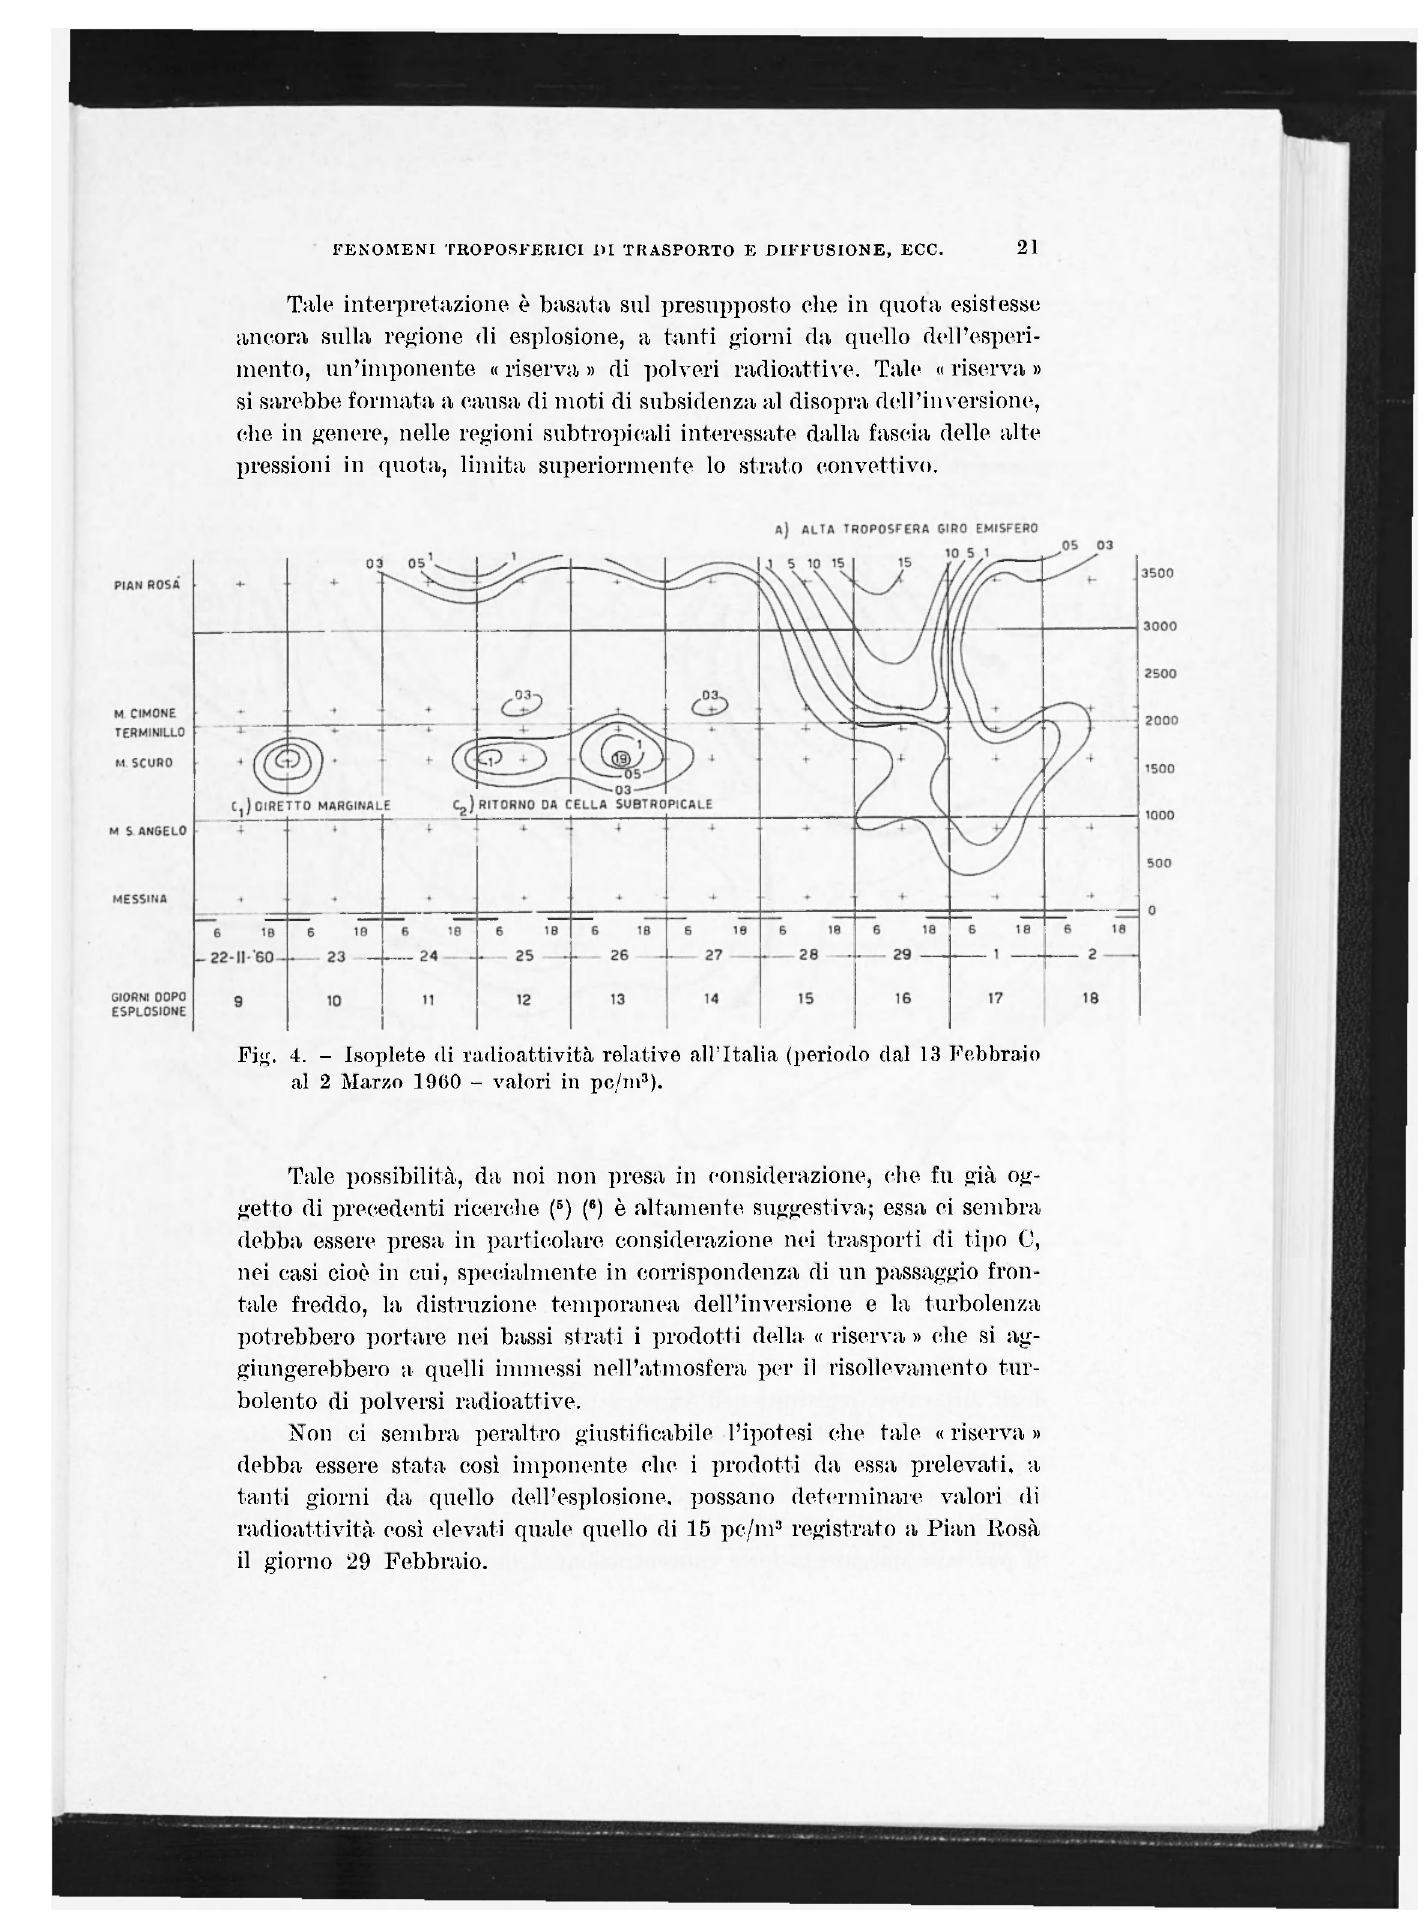
Fig. 4. - Isoplete di radioattività relative all'Italia (periodo dal 13 Febbraio al 2 Marzo 1960 - valori in pc/m 3